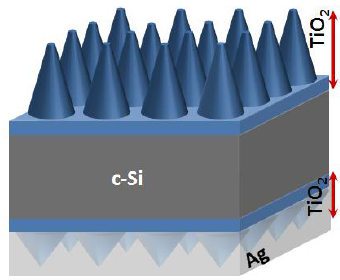
Figure 2. Proposed solar architecture consists of thin flat spacer titanium dioxide (TiO 2 ) layers on the front and rear surfaces of silicon, nanocone gratings on both sides with optimized pitch and height, and rear cones are surrounded by Ag metal reflector.